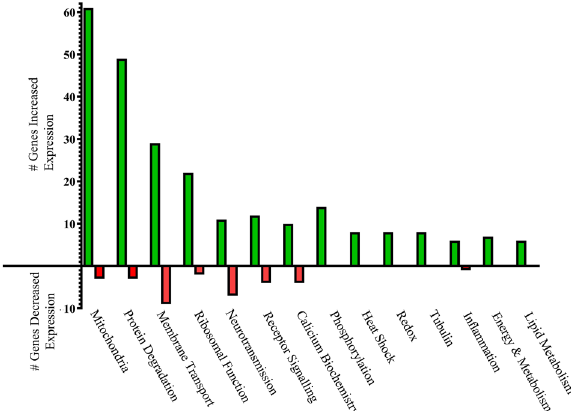
Fig. 1 Levels of gene expression in the cortex of the Chrm1 − / − compared to that in wild type mice. Volcano plot showing the levels of expression of 15,501 genes in the cortex of Chrm1 − / − compared to that in wild type (w/t) mice. Green dots = increased gene expression, red dots = decreased gene expression, black dots unchanged gene expression.